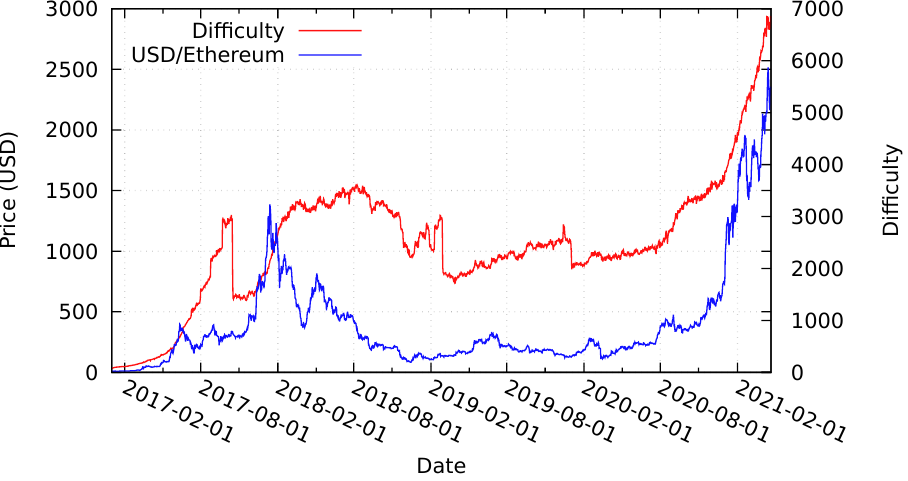
Figure 10. Average daily price of Ether in USD and block difficulty level between January 2017 and April 2021—partially based on [5,15], Data Source [69].